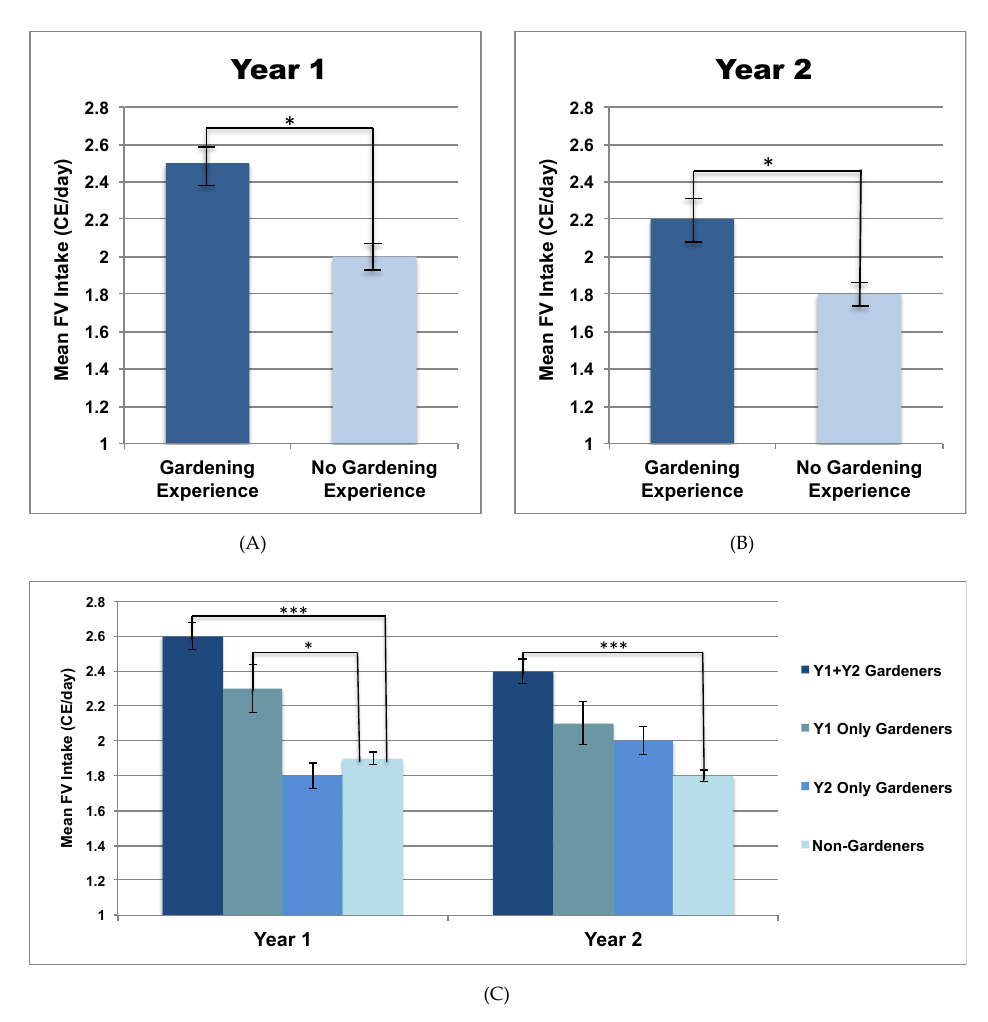
Figure 3. Fruit and vegetable (FV) Intake by College Gardening Experience. ( A ) Comparison of Y1 FV intake between those who did versus those who did not garden during the first year. ( B ) Comparison